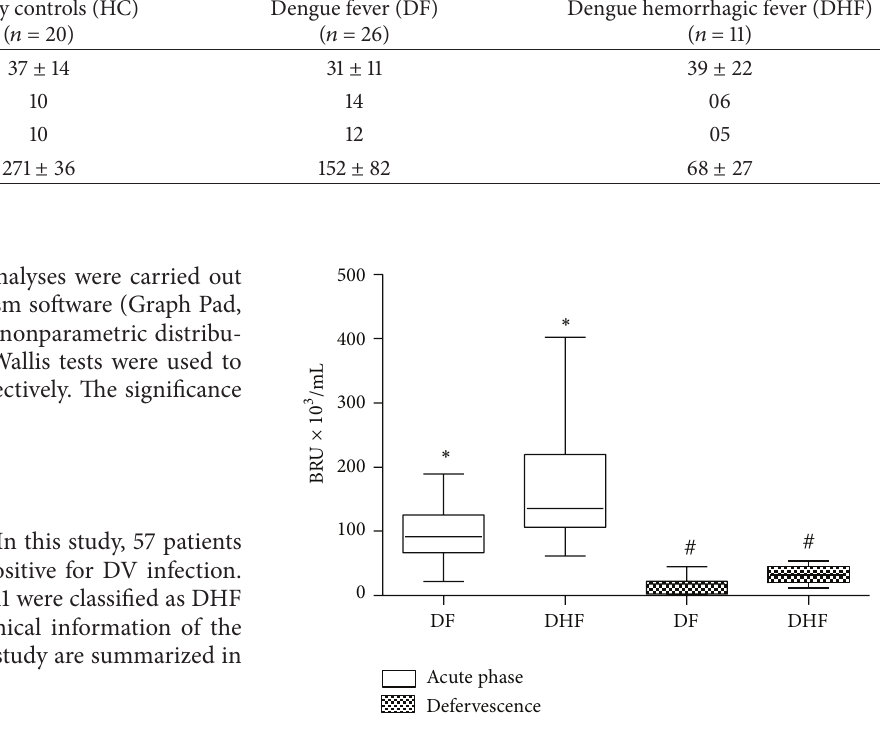
Figure 1: Dengue virus nonstructural protein 1 (NS1) serum levels of patients with dengue fever (DF, 𝑛 = 26 ) and dengue hemorrhagic fever (DHF, 𝑛 = 11 ) during the acute phase and convalescence, measured by ELISA and expressed as median BRU × 10 3 /mL in a box plot. Equivalent symbols ( ∗ , #) represent statistically significant differences ( 𝑃 < 0.05 ) between